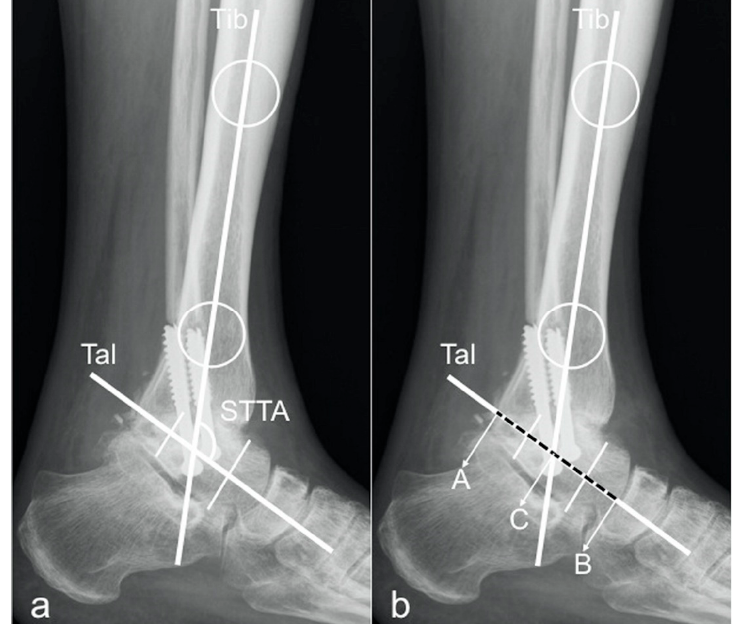
Figure 2. Method 2 for STTA and mTT-ratio measurement. Lateral ankle radiograph demonstrating Method 2: Tib = longitudinal axis of the tibia, created by connecting two points in the middle of the proximal and distal tibial shaft. Tal = or a line drawn connecting the midpoints of a line bisecting the talar neck and another line bisecting the talar body. Figure ( a ) depicts measurement of the sagittal tibio-talar angle (STTA). Figure ( b ) shows measurement of the mT-T